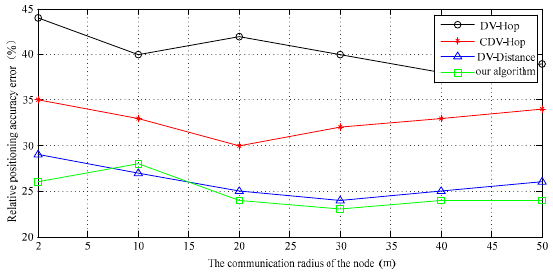
Figure 9. Localization error vs. Node communication radius.